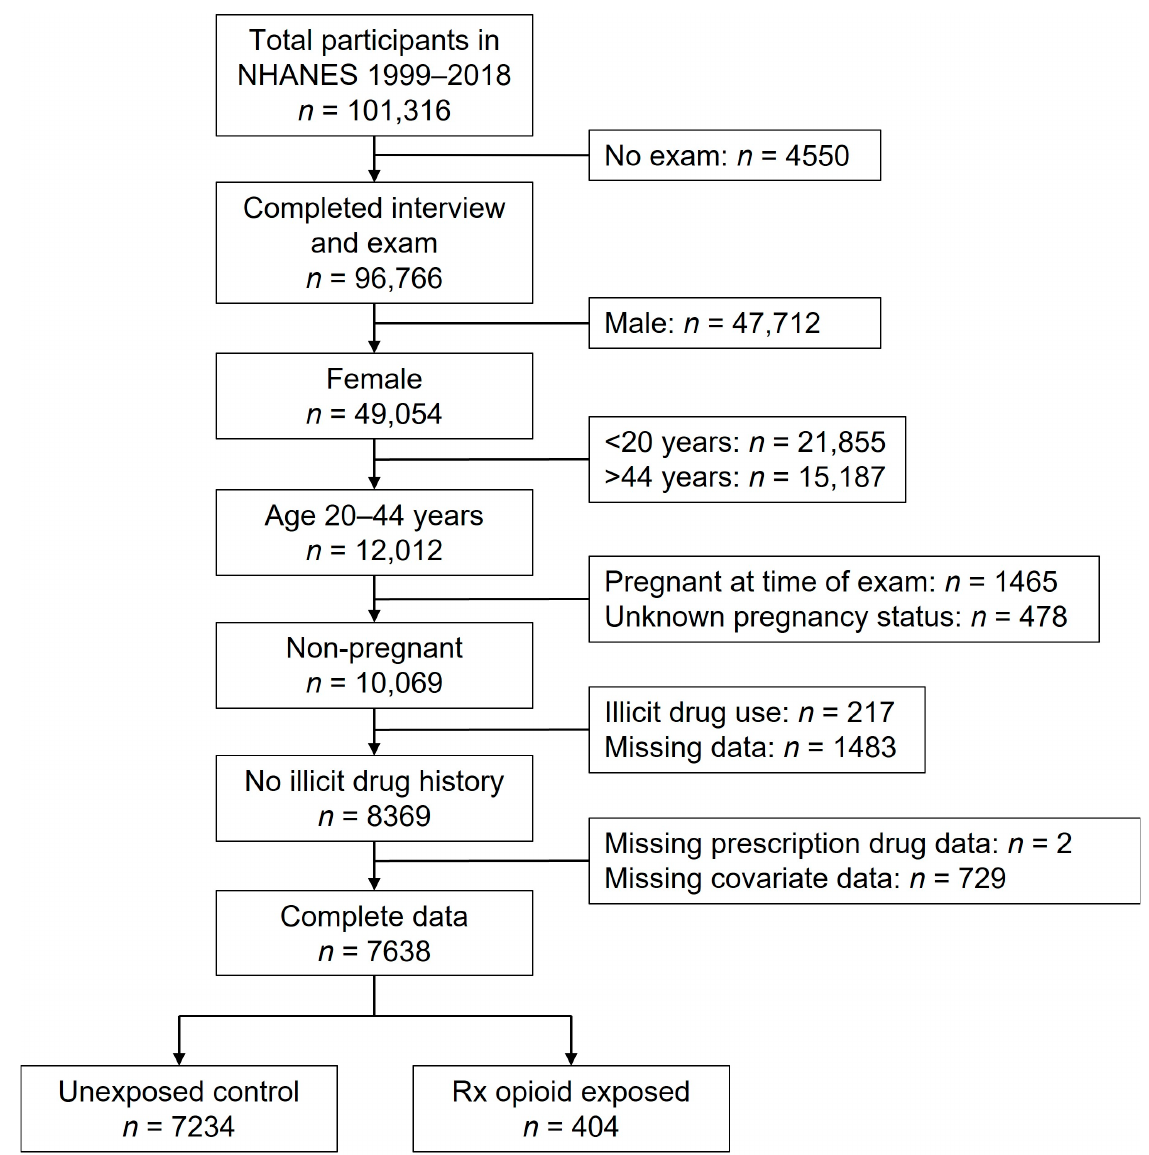
Figure 1. Participant flow diagram.